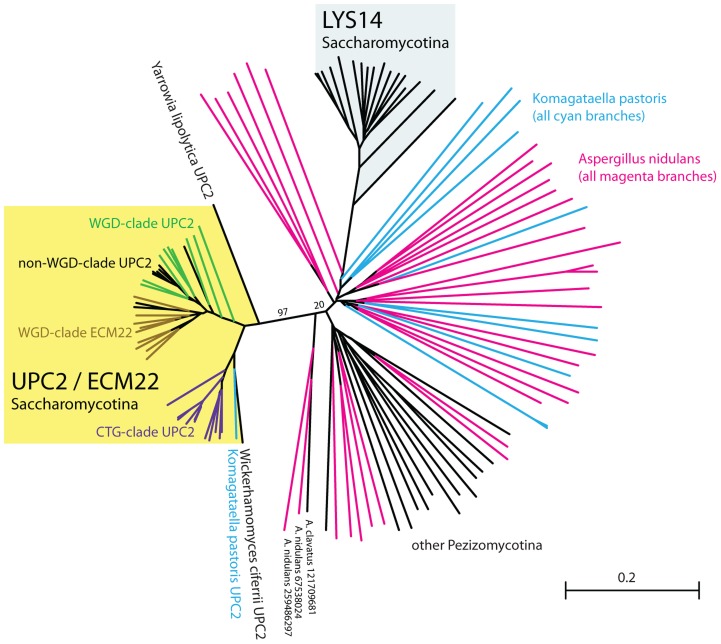
Upc2 has no clear orthologs outside the Saccharomycotina.This tree was constructed from sequences of Upc2 (and its ohnolog Ecm22 in WGD species); Lys14; and all Zn2Cys6 zinc finger protein genes in the genomes of two representative outgroup species, Aspergillus nidulans (magenta branches) and Komagataella pastoris (cyan branches) that have significant BLASTP hits (E<1e-6) when Upc2 proteins are used as a query. Also included are top-scoring BLASTP hits from other Pezizomycotina species (black branches). The tree was drawn by the neighbor-joining method without correction for multiple hits due to the high extent of sequence divergence. Bootstrap support for two key branches is indicated. NCBI gene identifier (gi) numbers are shown for the three sequences closest to the yellow Upc2/Ecm22 clade, but there is no evidence that these proteins are Aspergillus orthologs of Upc2. Scale bar represents 0.2 amino acid substitutions per site.